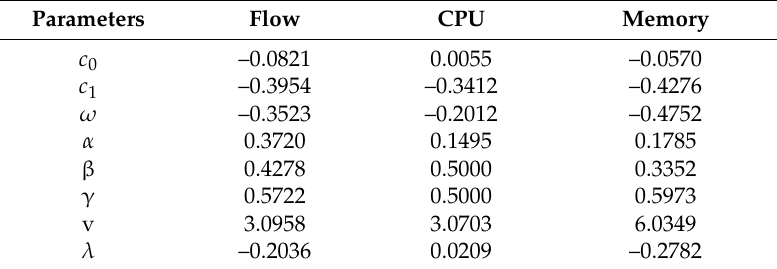
Table 2. The parameters’ values of estimation.